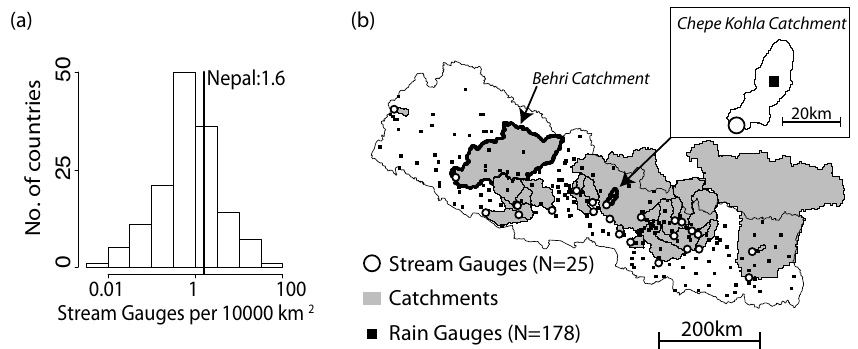
Figure 1. (a) Global histogram of the approximate spatial density of streamflow gauges by nation, represented by the sample of 8540 gauges indexed by the Global Runoff Data Center for 146 countries (Global Runoff Data Center, 2014). With a density of 1.6 gauges per 10000km 2 , Nepal falls close to the mode of the global distribution. (b) Location of the rain gauges, streamflow gauges, and corresponding Nepalese catchments used in the